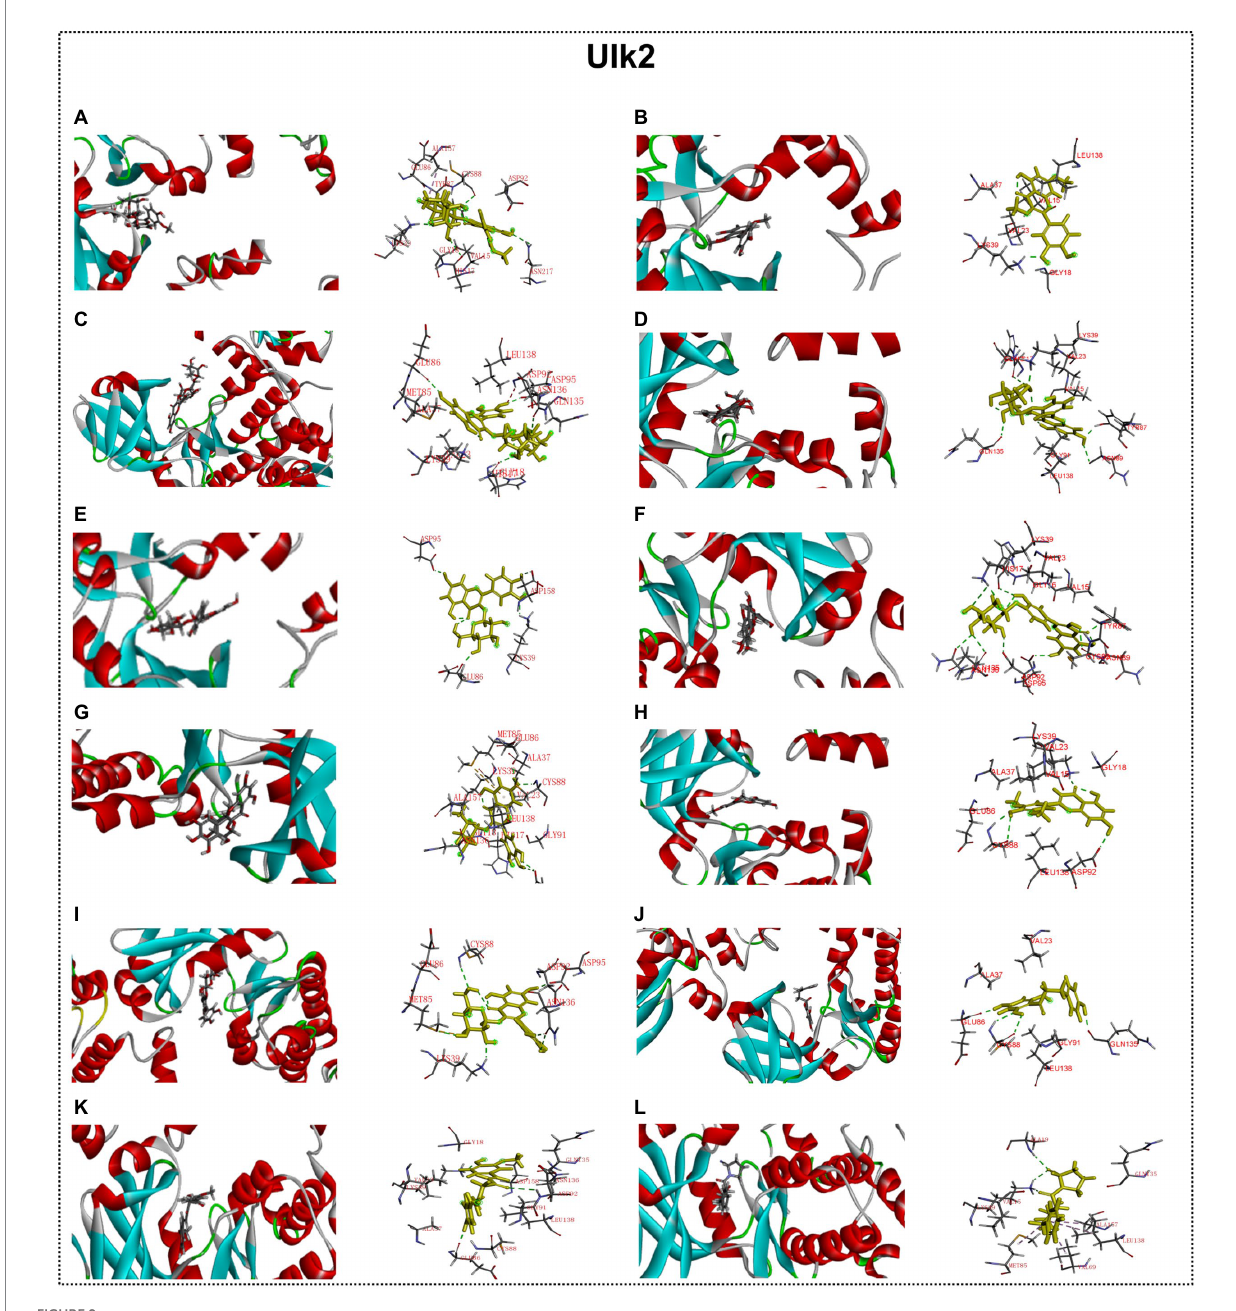
FIGURE 9 Docking simulation of the interaction between main flavonoid compounds of ECoL and the receptor UIk2 in general overview and local overview. Isorhamnetin-3-O-neohespeidoside (A) , di-O-methylquercetin (B) , rutin (C) , quercetin-3’-O-glucoside (D) , isoquercitrin (E) , spiraeoside (F) , myricitrin (G) , tricin (H) , hyperoside (I) , phloretin (J) , curcumin (K) , and KYP-2047 (L) were used as molecularly docked